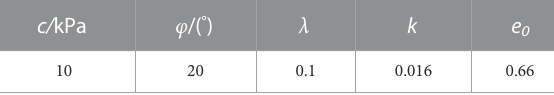
TABLE 2 The calculation parameters of MCCmodel.